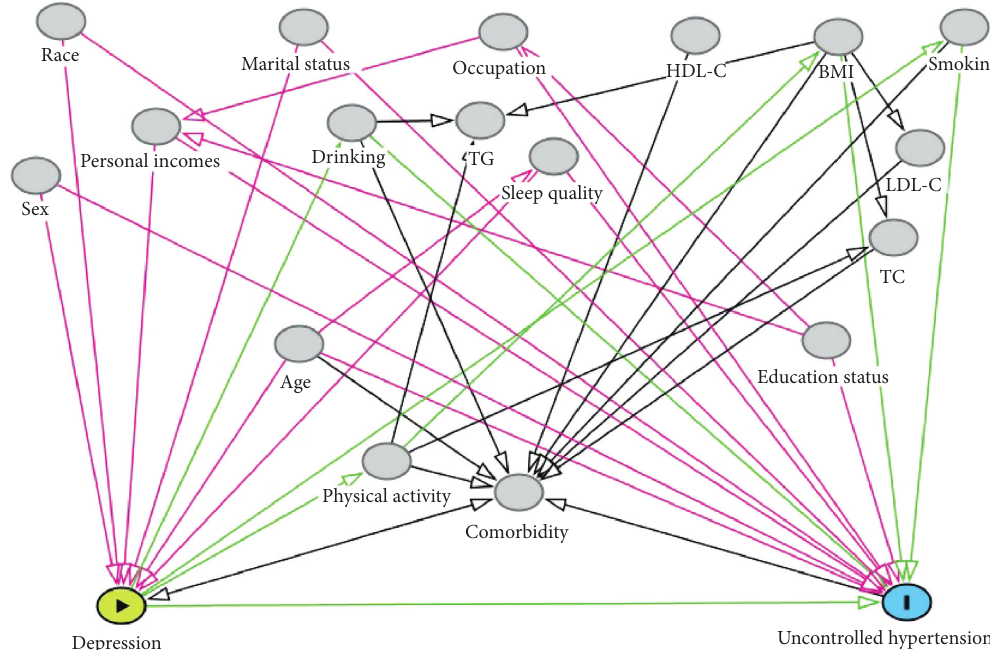
Figure 2: DAG derived from literature and expert knowledge. Nodes represent variables and arrows represent causal associations. Yellow- colored nodes and blue-colored nodes label depression and uncontrolled hypertension, representing exposure and outcome, respectively. Gray-colored nodes represent possible confounding factors. TC, total cholesterol; TG, triglycerides; LDL-C, low-density lipoprotein cholesterol; HDL-C, high-density lipoprotein cholesterol.